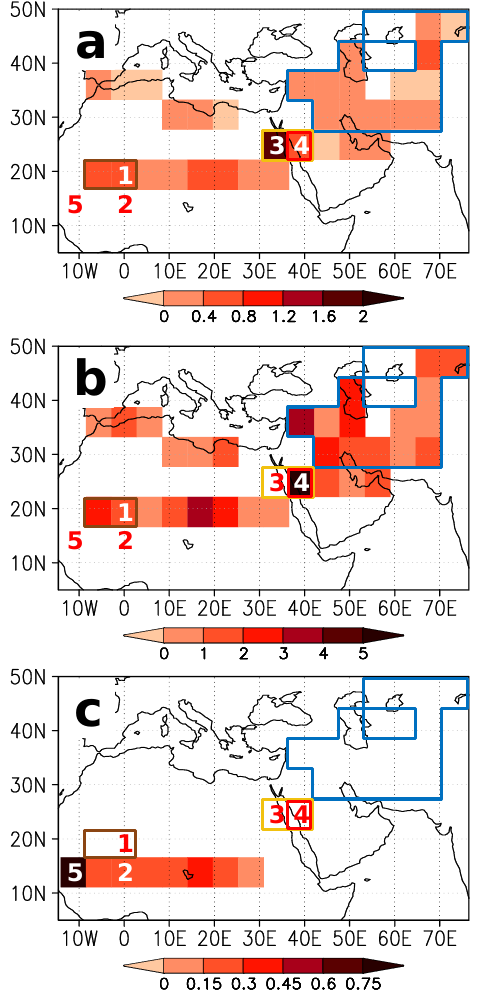
Fig. 6. Contribution of grid cells (weights) to the increasing auto- correlation as obtained with the hotspot detection algorithm, (a) in RM1; tipping point 1, (b) RM1; tipping point 2, (c) RM2. The noise in all time series is additive, hotspot detection is applied with n max =3, elimination rule 1, and covariance-based EOFs. Numbers 1 to 5 denote the individual grid cells referred to in the text. The coloured areas are the areas of our perturbation experiments ex- plained in Sect.